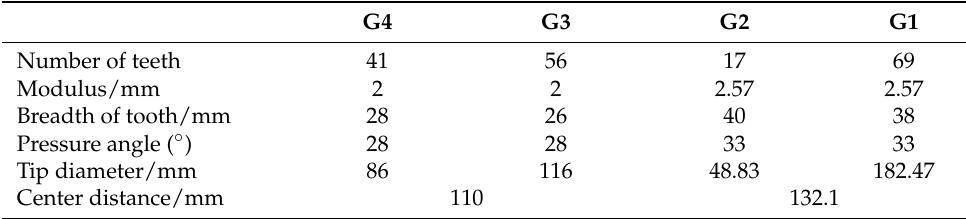
Figure 2. Three-dimensional model of transmission lubrication. Table 1. The basic geometric parameters of the gears.